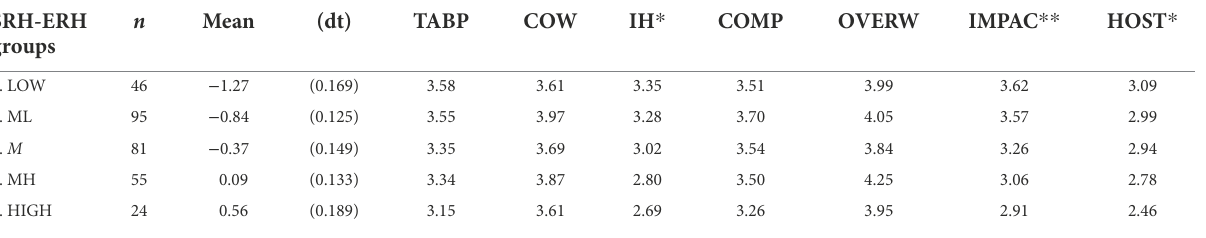
TABLE 23 Descriptive statistics for the groups formed ( n = 286). SRH-ERH